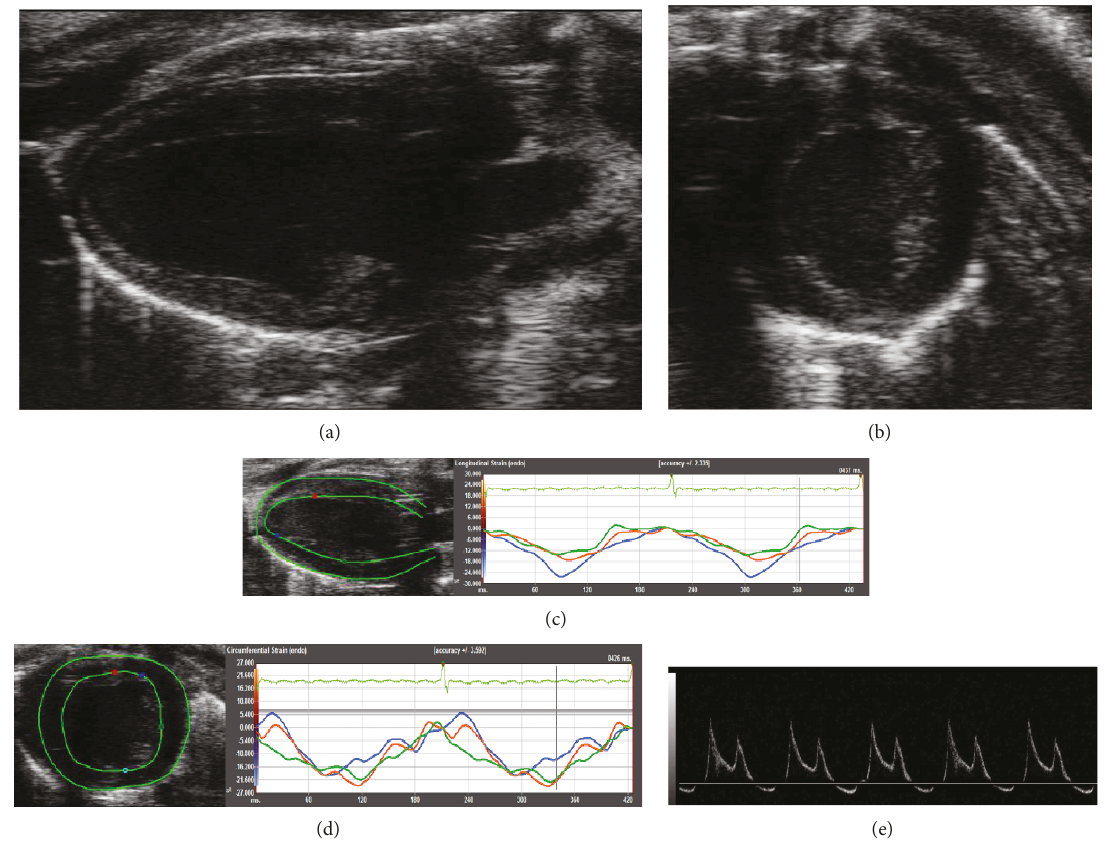
Figure 1: Cardiac ultrasound scan. (a) Parasternal long axis view of the left ventricle. (b) Parasternal short axis view of the left ventricle. (c) Analysis of the longitudinal and radial strain/strain rate. (d) Analysis of the circumferential and radial strain/strain rate. (e) Parasternal 4-chamber view with PW-Doppler for the evaluation of E/A